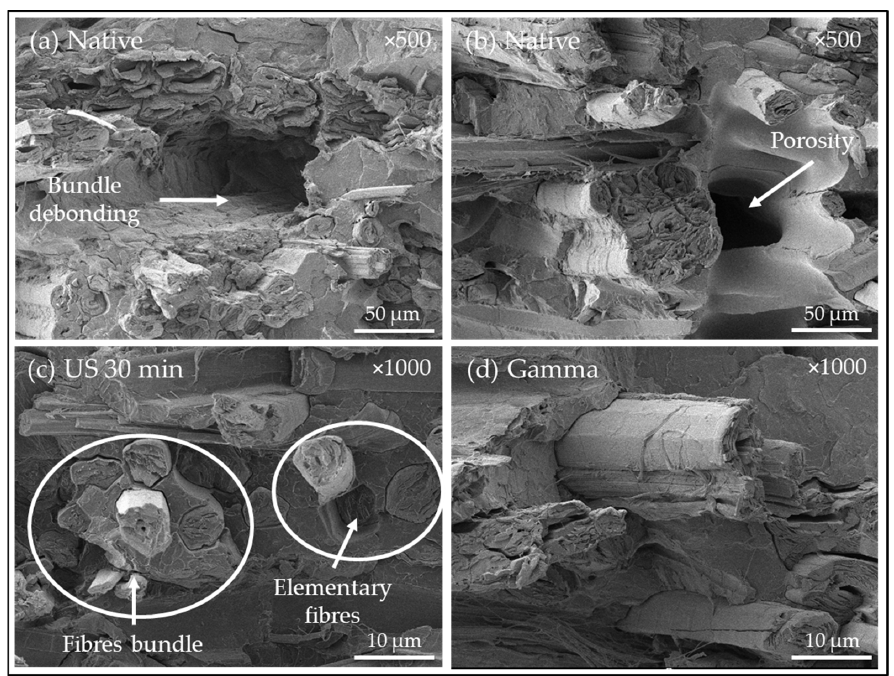
Figure 12. SEM observations of the interface of non-woven composites: ( a ) Debonding of fibre bundles; ( b ) porosity; ( c , d ) fibre bundles and elementary fibres in the US 30 min and Gamma composites, respectively.